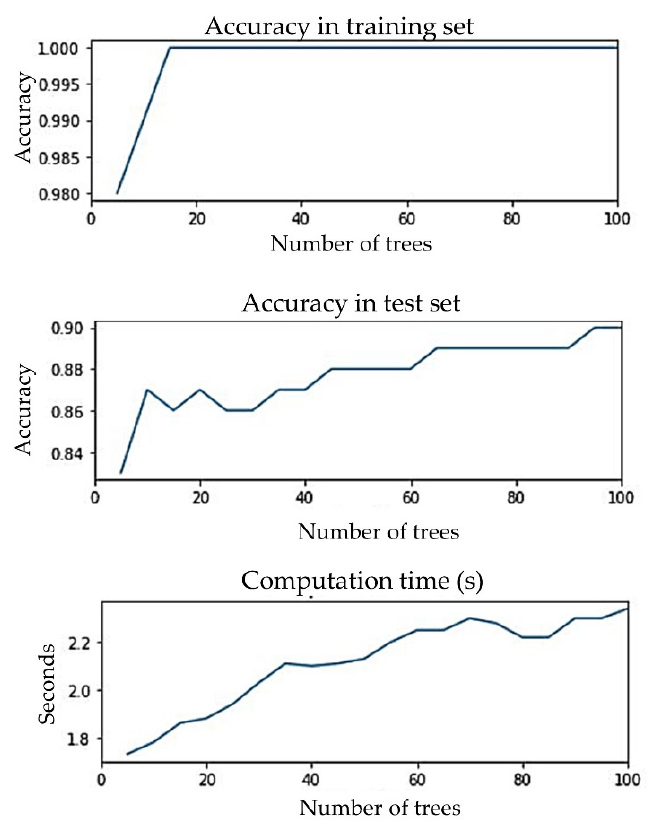
Figure 10. Accuracies of training and test set and computation time for different numbers of trees.